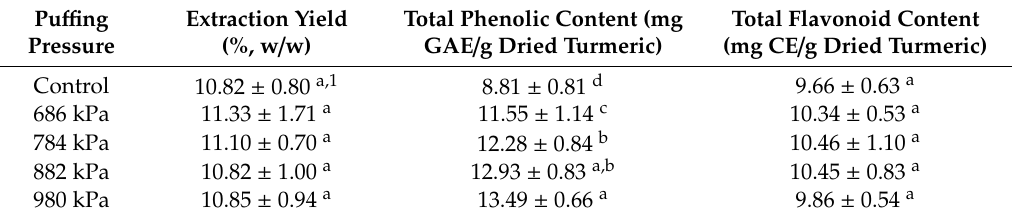
Table 2. Extraction yield, TPC, and TFC ( n =